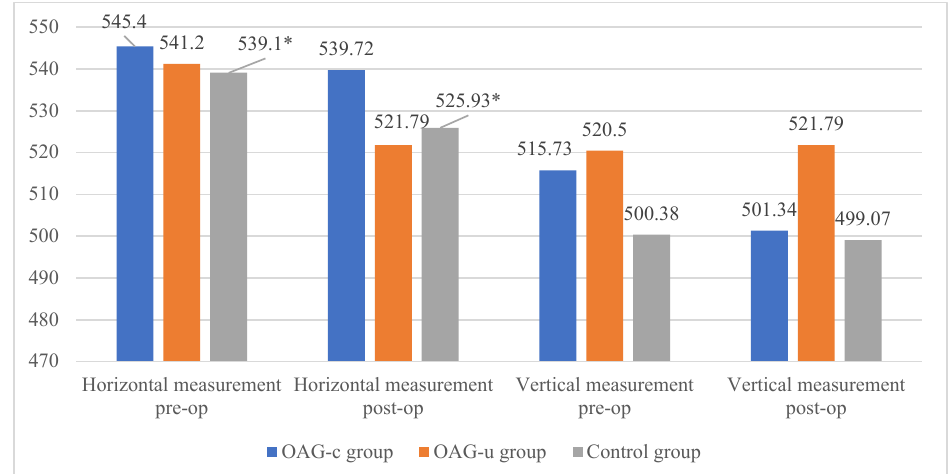
Figure 13. FAZ horizontal and vertical measurements of deep capillary plexus before and 6 months after cataract surgery. Vertical axis shows mean FAZ horizontal and vertical measurements ( µ m). Statistically significant measurements (*) ( p < 0.05).